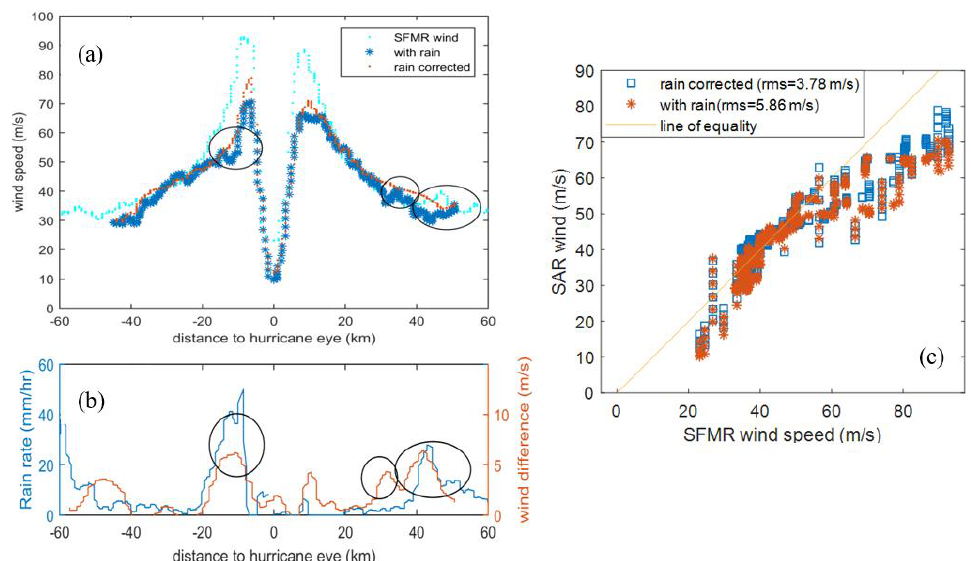
Figure 10. Comparisons of wind speed before and after rain flag along the NOAA flight. ( a ) Wind speed along SFMR track, ( b ) rain rate from SFMR measurements and associated speed difference from SAR, ( c ) scatterplot of wind speed before and after rain correction as compared to SFMR wind measurements. Note: the capability of the proposed method to recognize the strong precipitation areas is highlighted in the circled areas of ( a , b ).